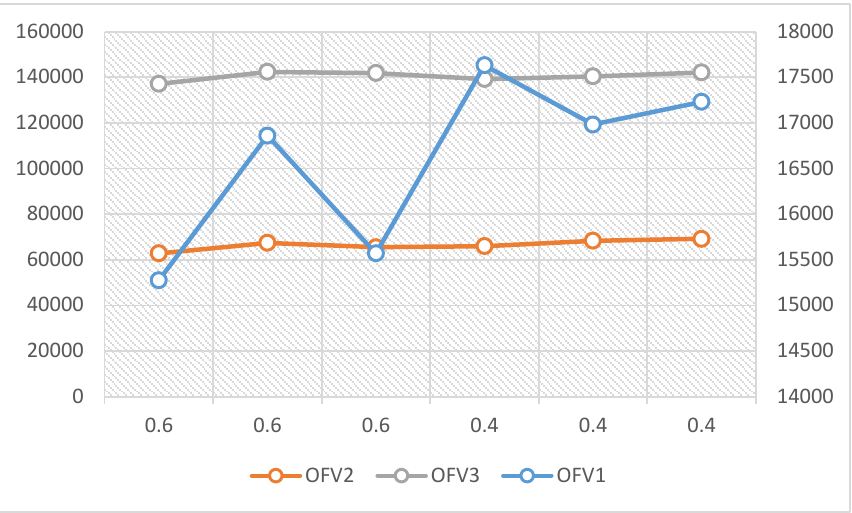
Figure 10. Objective function values of the TH method for test problem